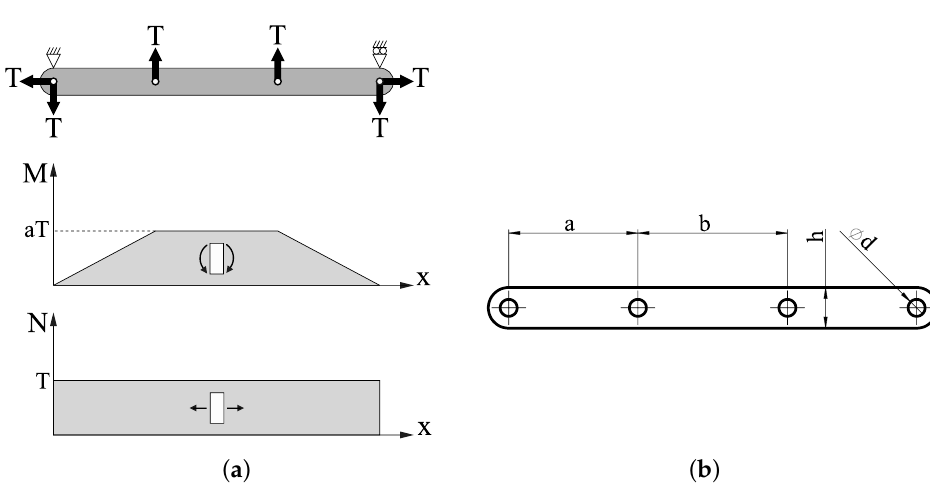
Figure 6. ( a ) Forces on the measuring bar. ( b ) Geometry of the measuring